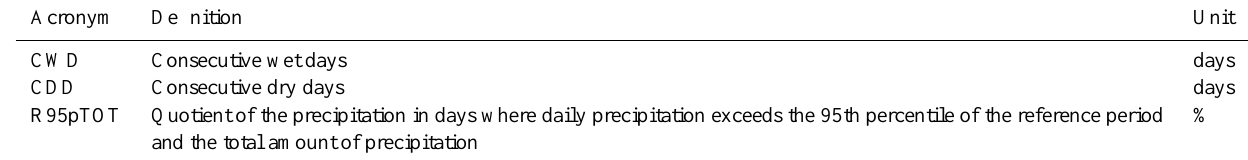
Table 1. Extreme indicators considered in the